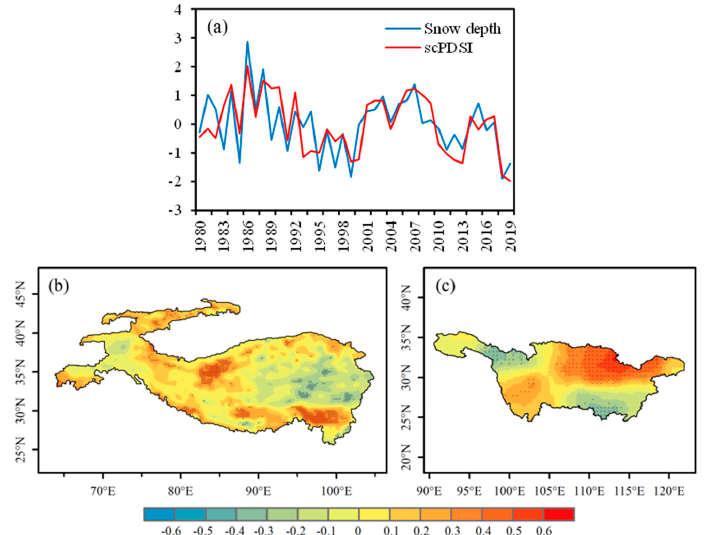
Figure 7. The spatial distributions of the left and right fields of the second SVD mode and their time series, derived from winter snow depth of HMA and the succeeding spring scPDSI of YRB during the period 1980–2019. ( a ) Normalized time series of winter snow depth (blue line) and spring scPDSI (red line)—units are arbitrary; ( b ) snow depth of HMA and ( c ) scPDSI of YRB—dotted area means passing significance test of 0.05.